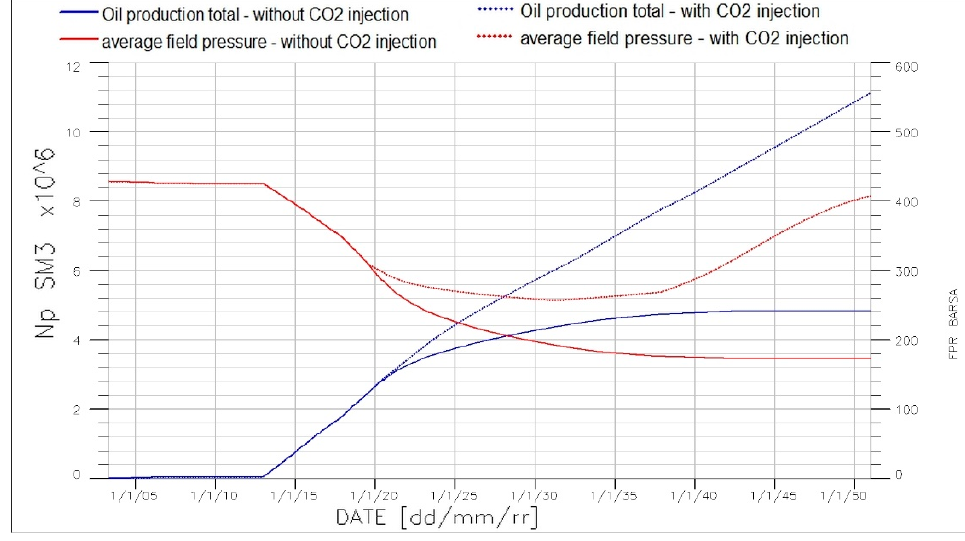
Figure 18. Comparison of primary production and EOR with CO 2 injection. Total oil production, N p ; and average reservoir pressure, FPR.